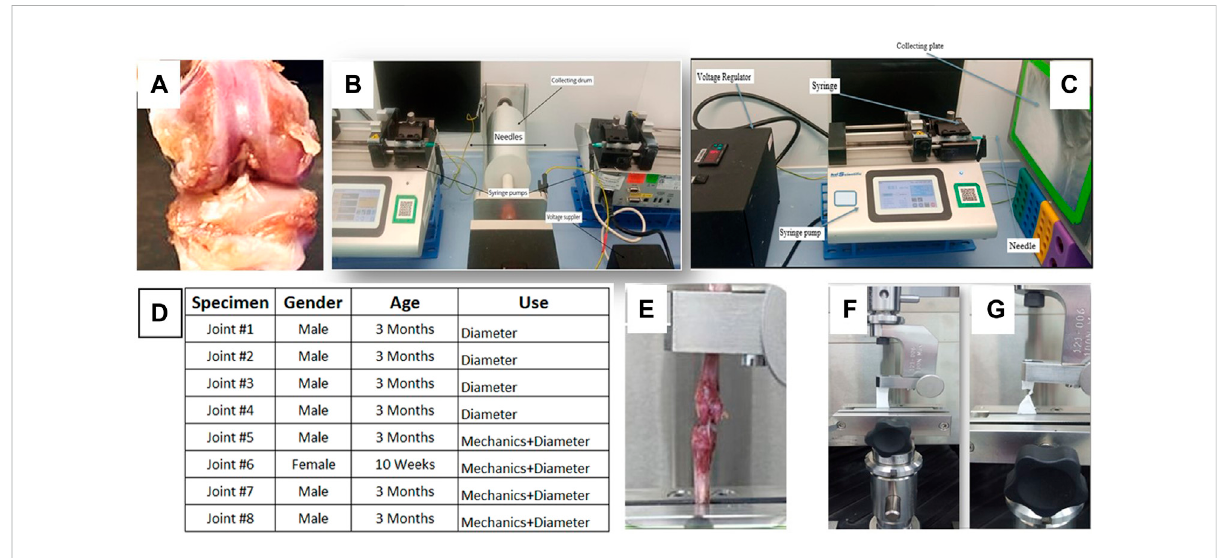
FIGURE 1 (A) Grossviewoftheratkneejoint,electrospinningset-upfor (B) alignedbimodaland (C) randomunimodalPCLconstructs, (D) genderandage of rat ACL tissues, mechanical testing apparatus for (E) rat ACL and (F,G) PCL